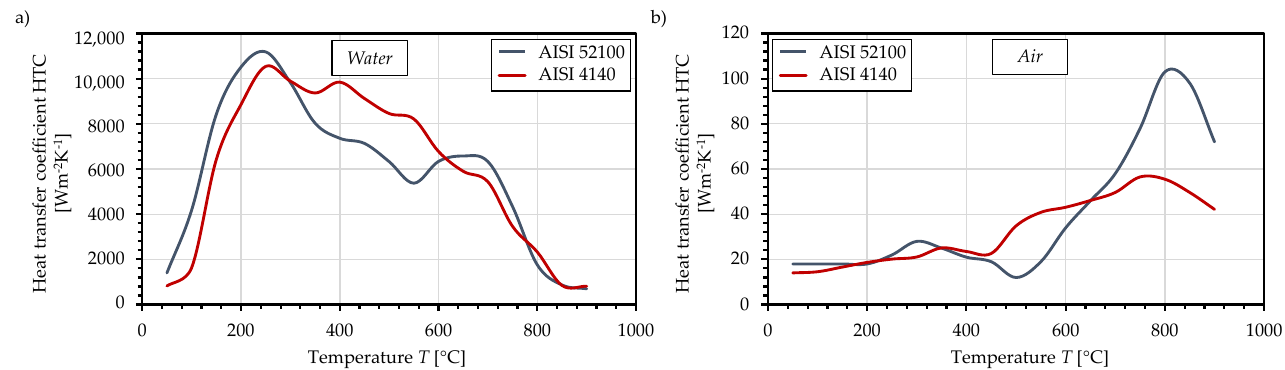
Figure 3. Numerically-identified heat transfer coefficients between the steel alloys (AISI 52100 or AISI 4140) and the media water ( a ) or air ( b ).